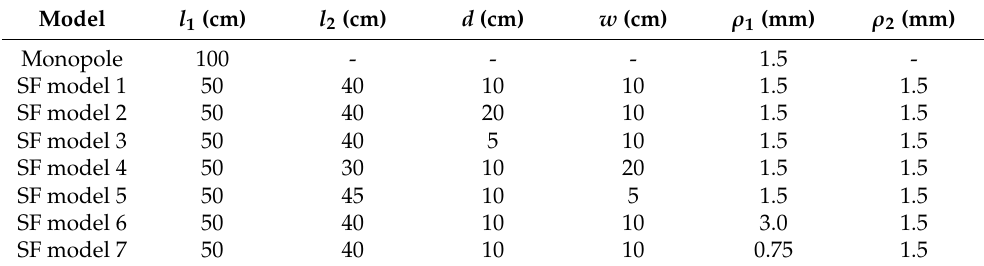
Figure 1. The parameters of the single-fold (SF) monopole. Table 1. Dimensions of the monopole and single-fold (SF) antennas.